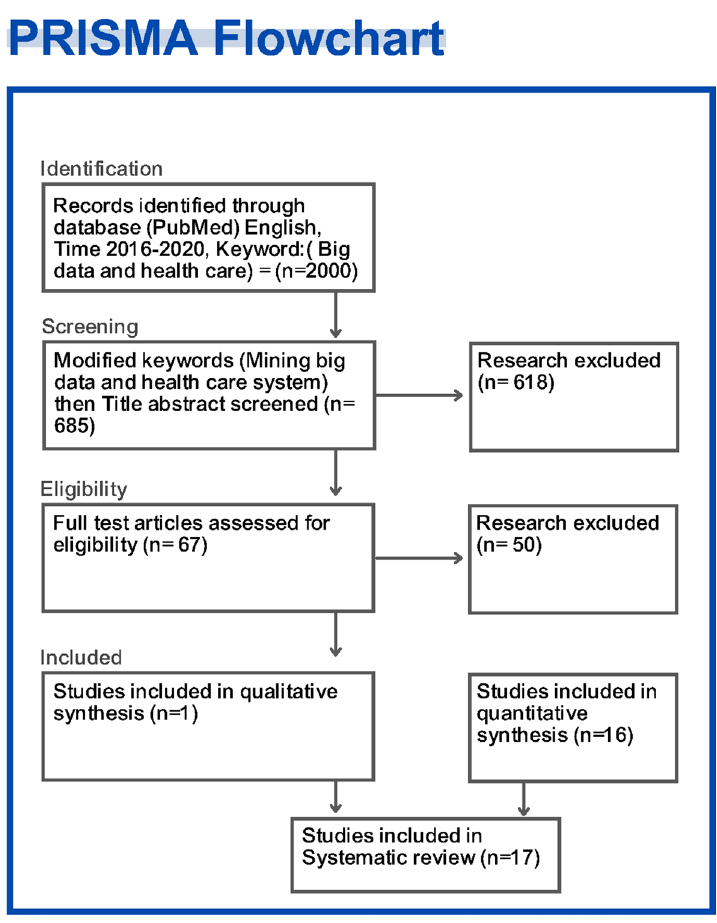
Fig. 3 PRISMA Results of Flow of information through the different phases of a systematic